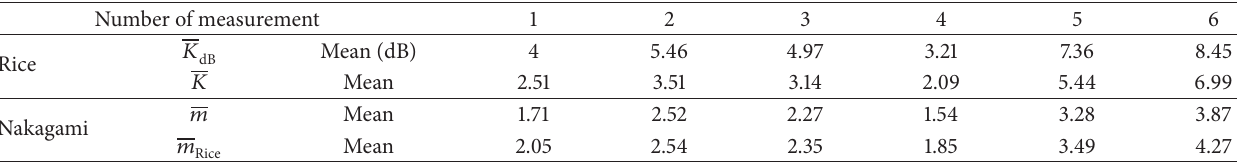
Table 5: Sample mean of the Rice 𝐾 -factor in logarithmic units and linear units. Sample mean of the fading parameter and mean of fading parameter calculated from the Rice 𝐾